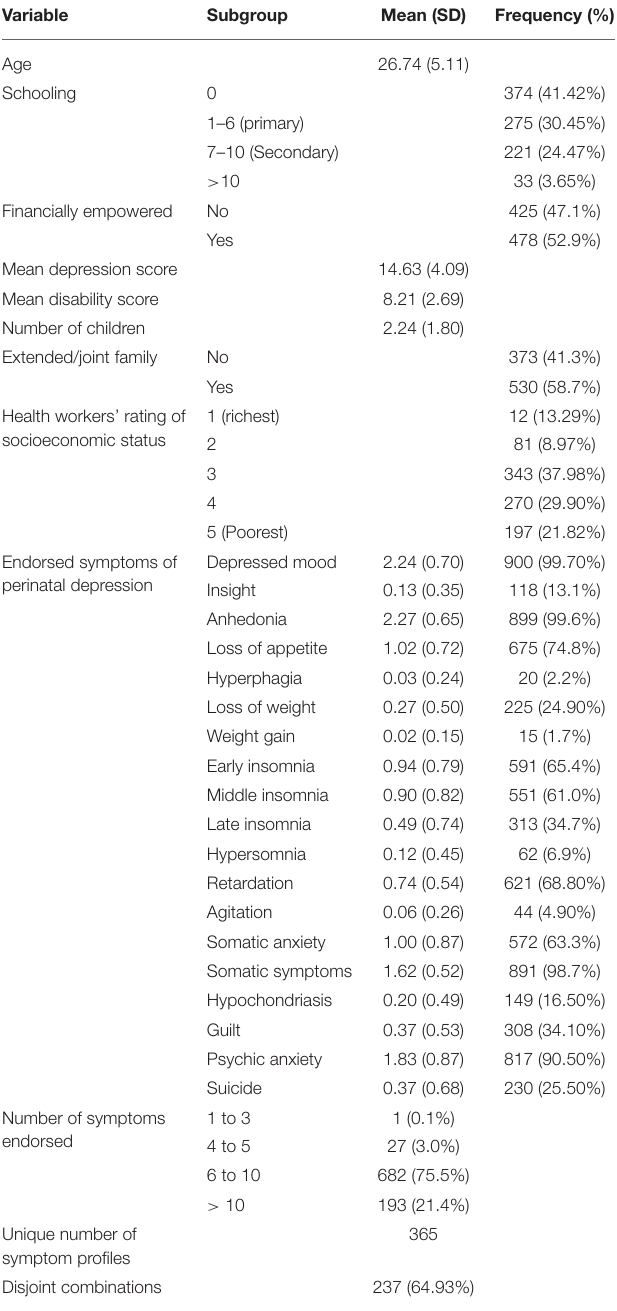
TABLE 1 | Demographics and baseline characteristics of study participants ( n = 903).